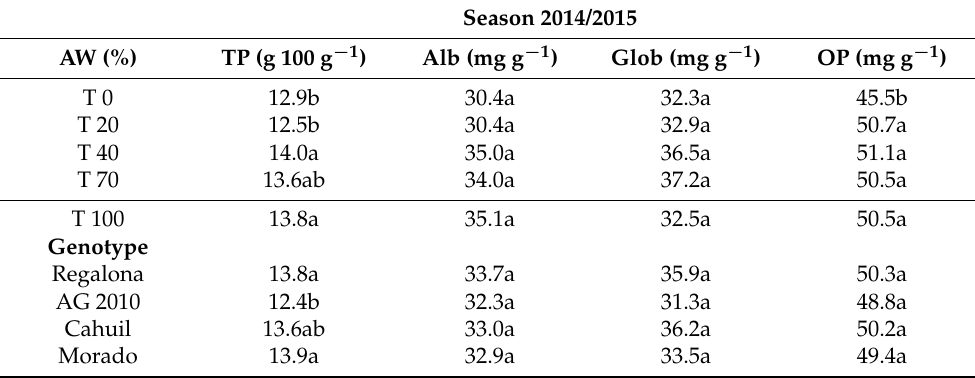
Table 2. Total protein (TP) content, albumin (Alb), globulin (Glob), and other dissolved proteins (OP) in five water availability treatments (T) and four quinoa genotypes for the 2014/2015 and 2015/2016